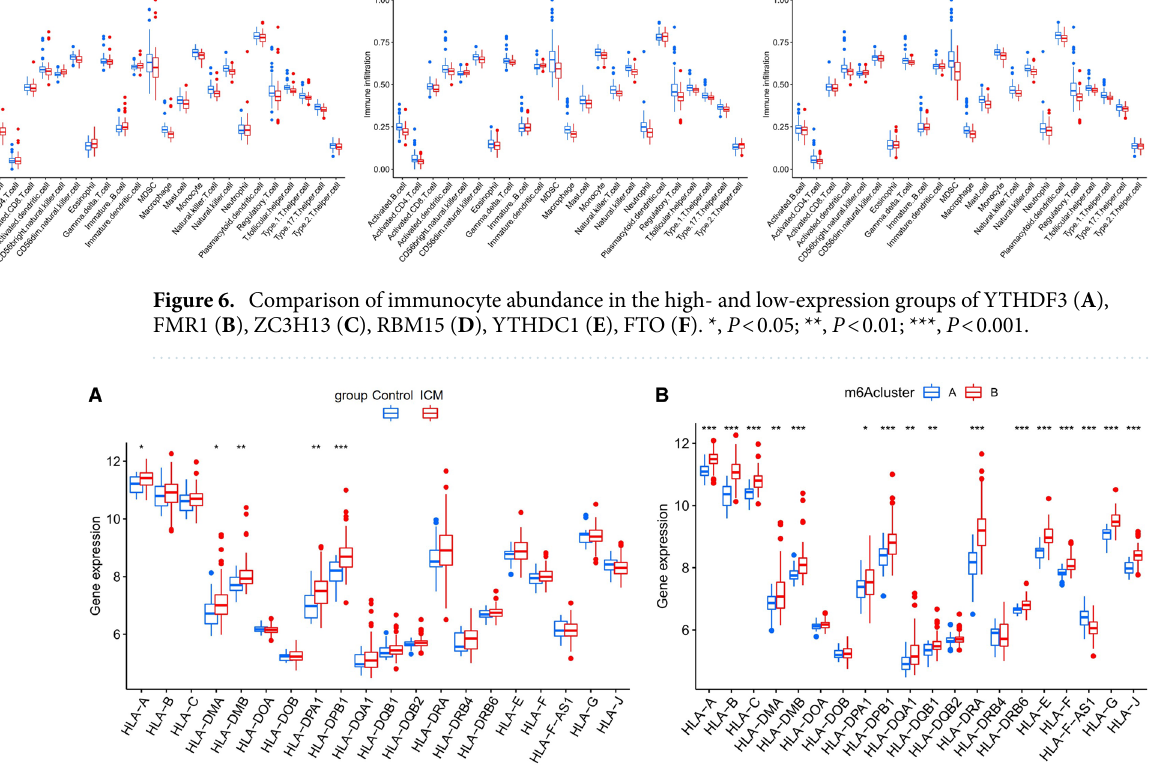
Figure 7. The differences in the expression levels of each HLA gene between the control and ICM groups ( A ); m6A cluster-A and -B groups ( B ). *, P < 0.05; **, P < 0.01; ***, P <